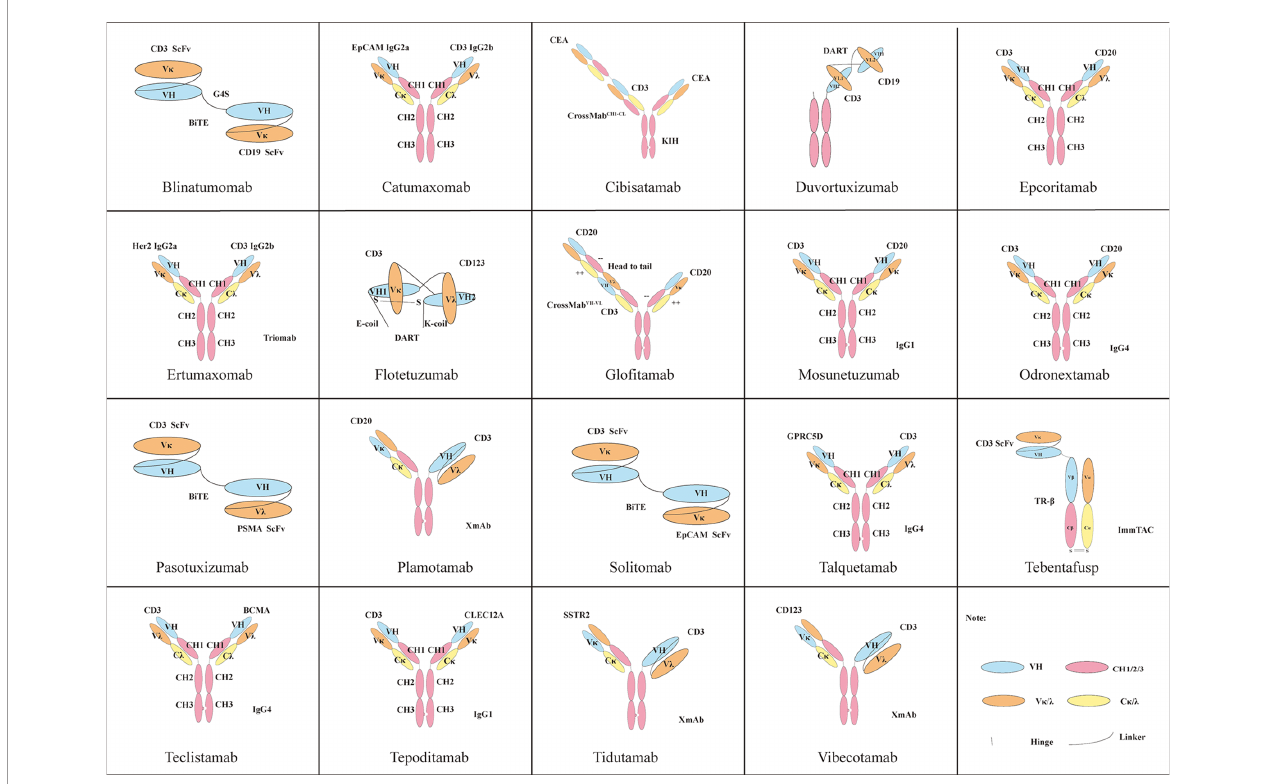
FIGURE 2 | Some classic structures of BsAbs with CD3 as one of their